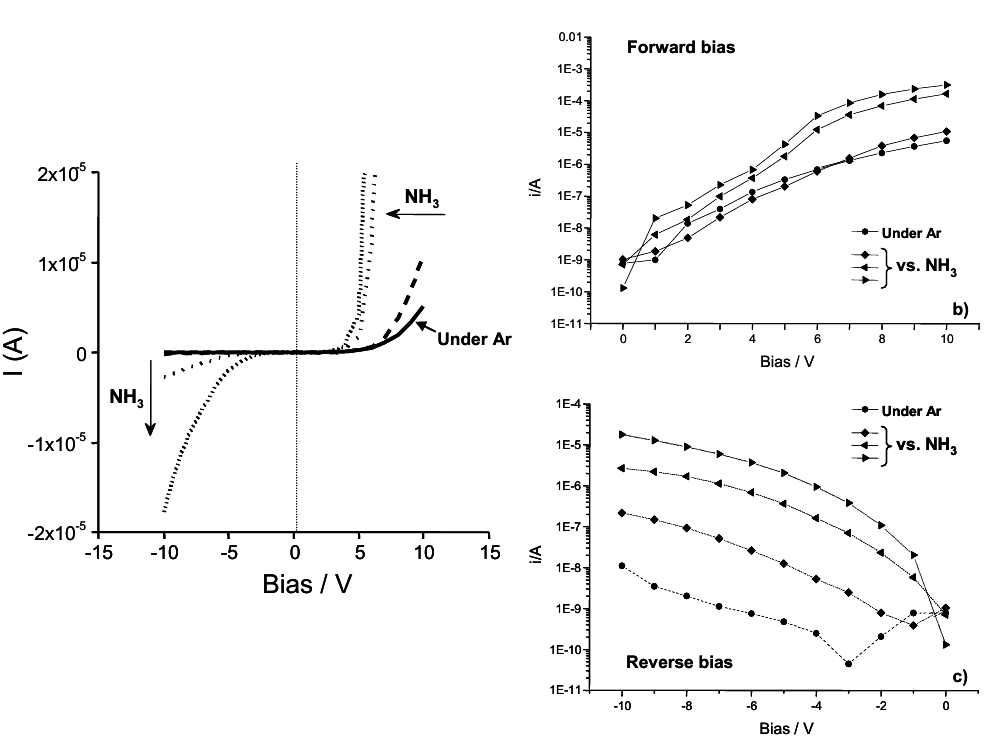
(from a 10% aqueous solution) on the I-V behavior of Au|NiPc|Ni(F Figure 5. Effect of NH 3 in linear scale (a), and in semi-logarithmic scale for forward (b) and reverse (c) bias, respectively.